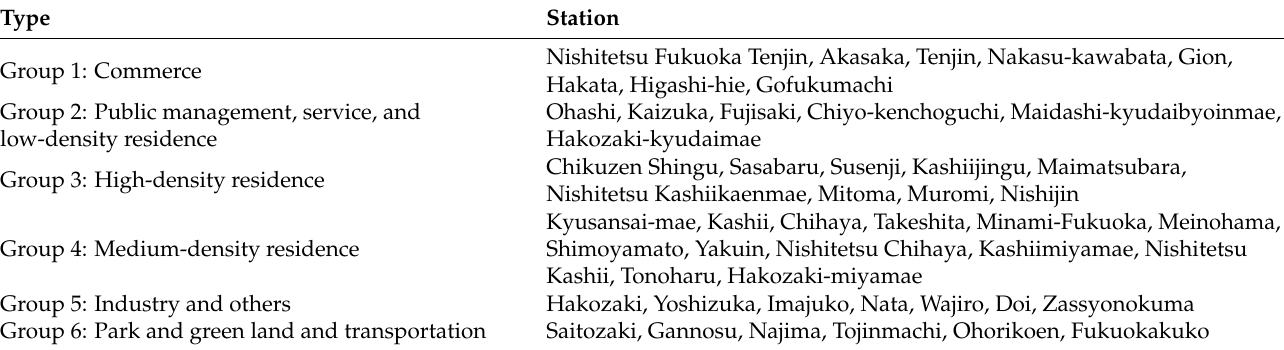
Table 11. Station classification in 400–800 m radius after cluster analysis.